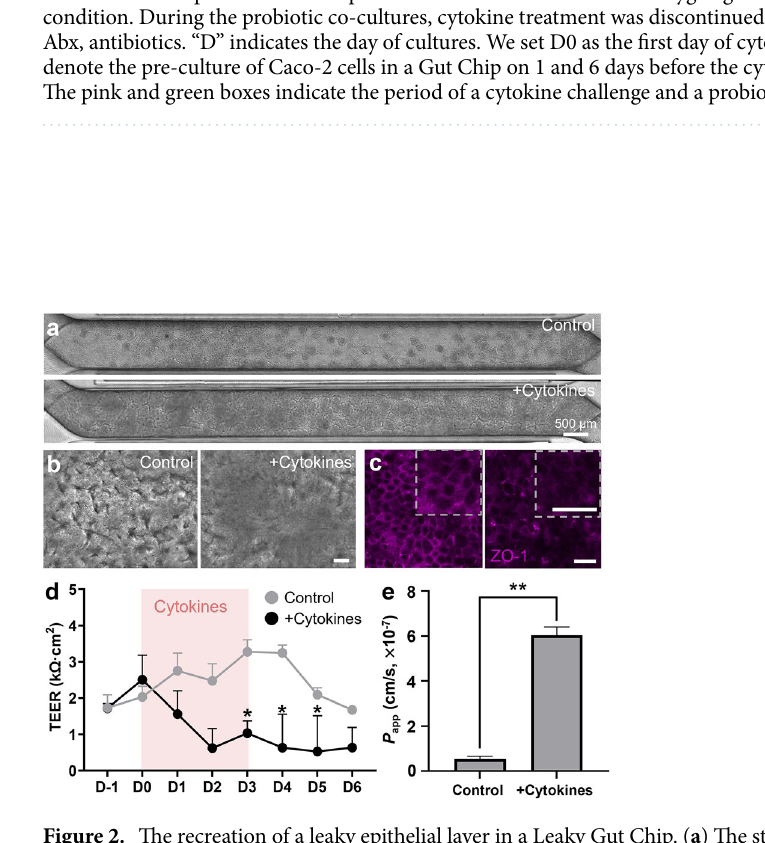
Figure 2. The recreation of a leaky epithelial layer in a Leaky Gut Chip. ( a ) The stitched phase-contrast views of epithelial layers across the entire microchannel in the absence (Control) or the presence of a cytokine cocktail (+ Cytokines; 100 ng/mL TNF-α and 100 ng/mL IL-1β) taken on day 3 (D3) since the cytokine treatment. ( b ) High-power magnification of epithelial morphology visualized by DIC microscopy in the absence (Control) or the presence of a cytokine cocktail (+ Cytokines). ( c ) Immunofluorescence micrographs that highlight ZO-1 in the absence (Control) or the presence of a cytokine cocktail (+ Cytokines). An inset (a dashed square) in each panel shows a high-power magnification of the part of the provided immunofluorescence image. ( d ) The profile of epithelial barrier function quantitated by TEER measurement as a function of time in the absence (Control; n = 5) or the presence of a cytokine cocktail (+ Cytokines; n = 6). A pink box in the chart illustrates the period of cytokine treatment for 72 h. * p < 0.05. ( e ) Apparent permeability ( P app ) calculated by the fluorescein transport assay across the epithelial interface in a Leaky Gut Chip without (Control) or with a cytokine mixture (+ Cytokines). ** p < 0.01. Bars are 50 µm, unless otherwise